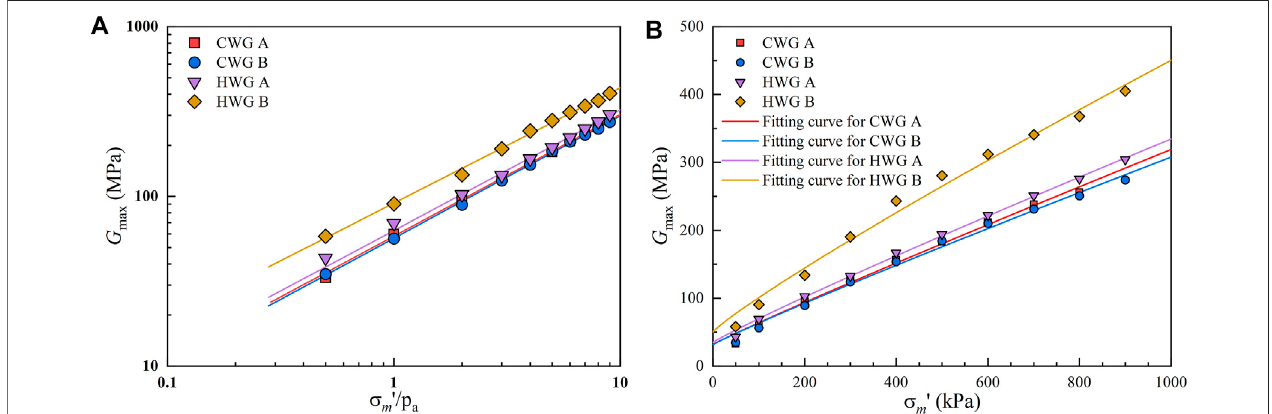
Figure 9A . A highly signi fi cant linear relationship between the maximum dynamic shear modulus and effective consolidation stress was observed in the logarithmic coordinate for all samples and can be expressed by the common power function as follows.